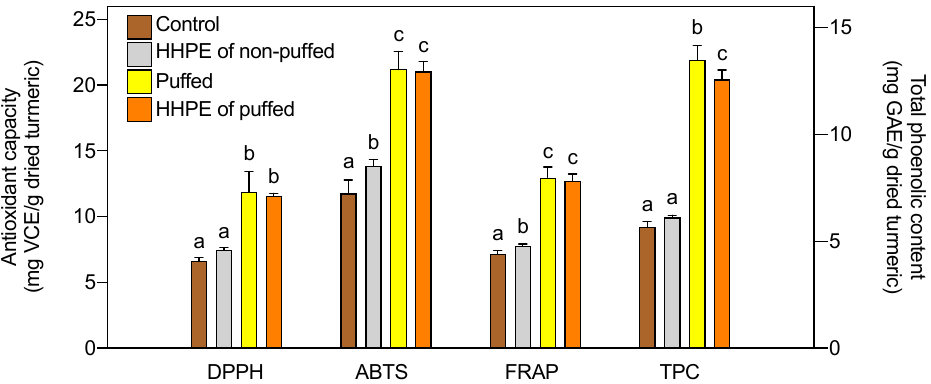
ff ect of pu ffi ng and HHPE on antioxidant activities and total phenolic contents Figure 2. Combination effect of puffing and HHPE on antioxidant activities and total phenolic Figure 2. Combination e (TPC) of turmeric. Same letters in each group indicates that they are not statistically di ff erent at p < 0.05.